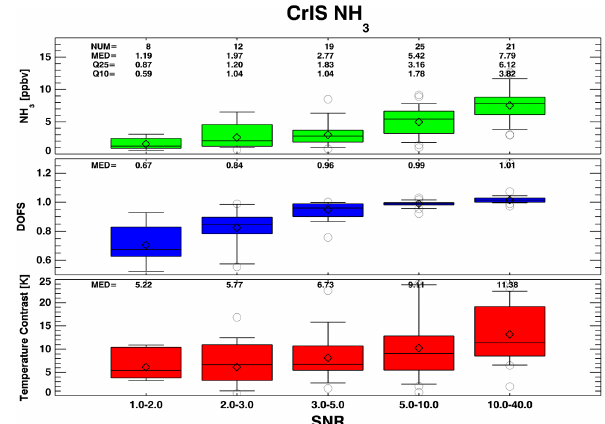
Figure 5. Box-and-whiskers plot of the simulated values from Fig. 4 for the peak NH3 profile values, measurement sensitivity (DOFS), and temperature contrast, all binned as a function of | SNR | . The boxes edges are the 25th and 75th percentile, the line in the box is the median, the diamond is the mean, the whiskers are the 10th and 90th percentiles, and the circles are the outlier values outside the